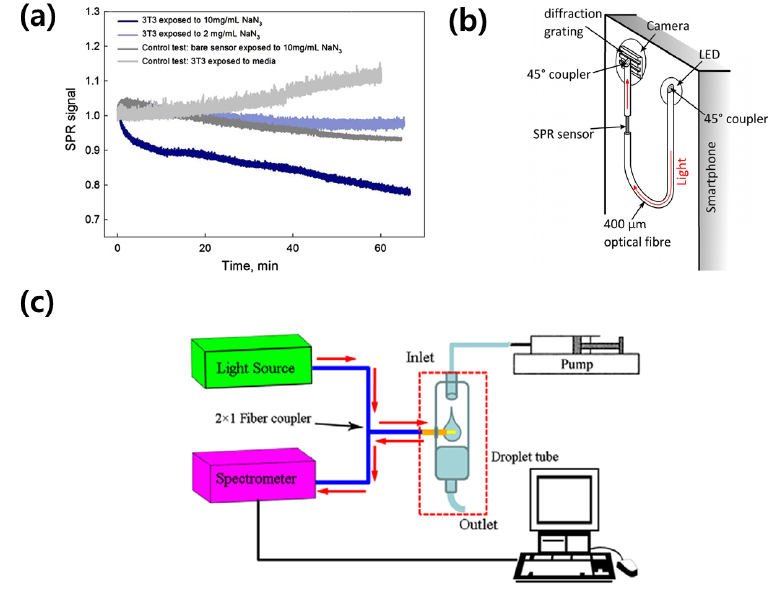
Figure 2. Advanced fiber-based SPR sensors. ( a ) SPR signals when cells cultured on the fiber-optic based SPR sensor (inlet in (a)) for cellular chemical reaction measurements were exposed to sodium azide (NaN 2 ) with several concentrations (10, 2 and 0 (control) mg/mL). A SPR signal of 10 mg/mL